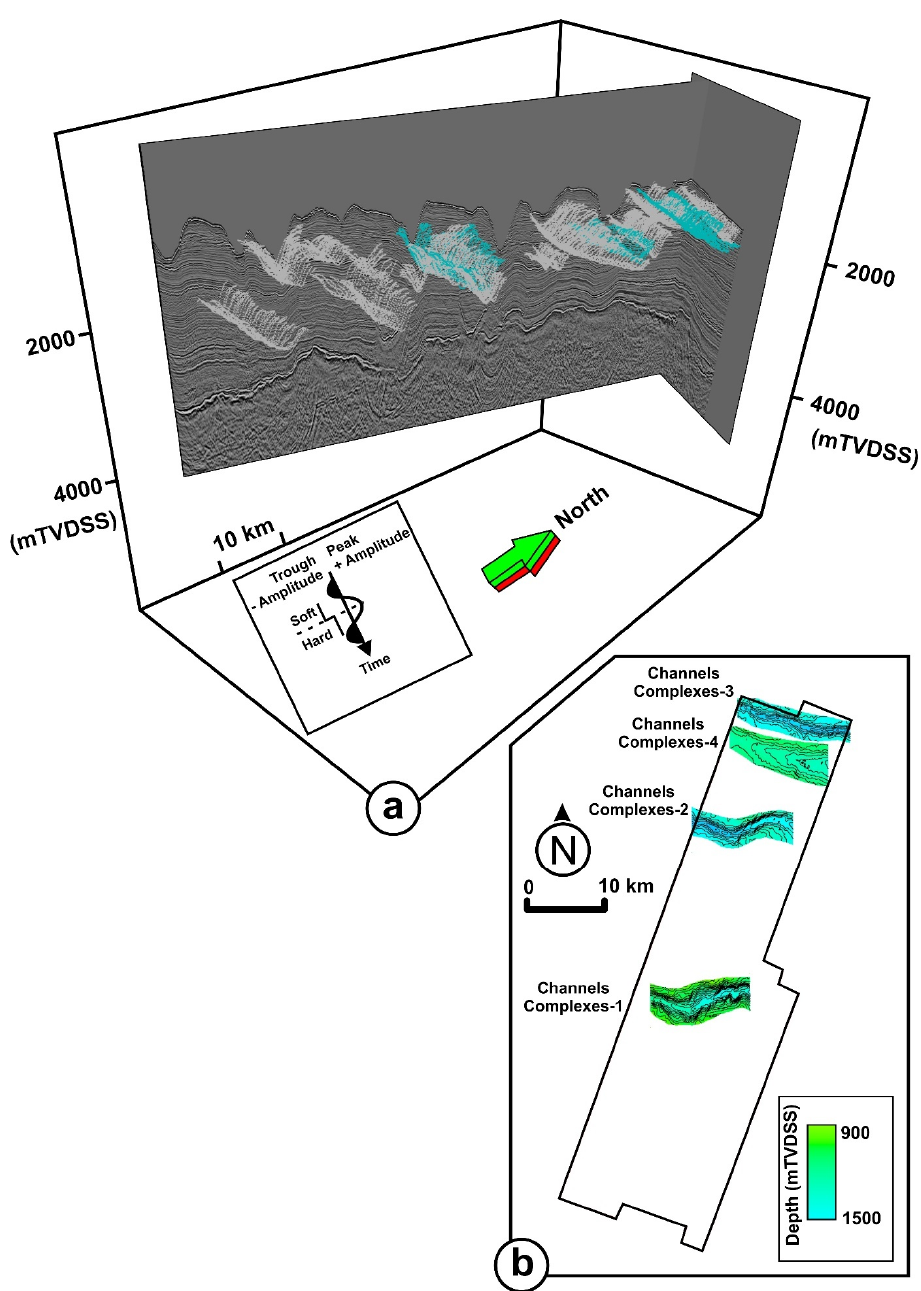
Figure 4. ( a ) Three-dimensional view of 18 continental slope channels complexes with inline and crossline seismic amplitude (the 4 represented channels complexes are marked by the blue color), and ( b ) Plan view of the 4 represented channels complexes. See Figure 1a for coordinate information.